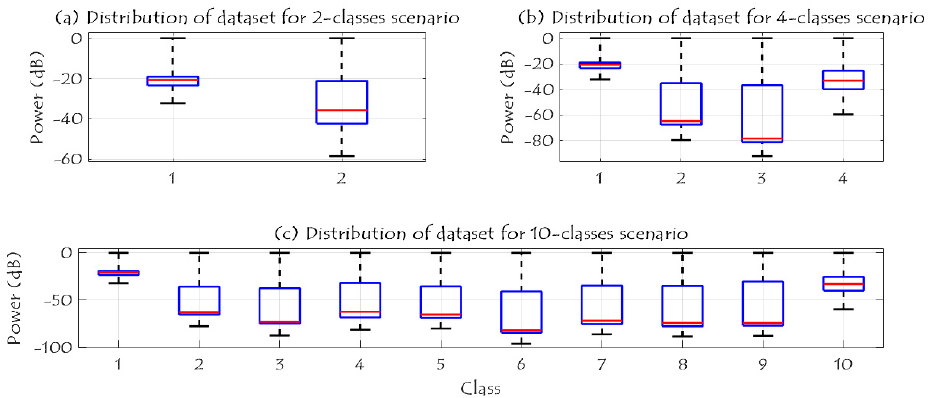
Figure 10. Data distribution for 2, 4, and 10 classes